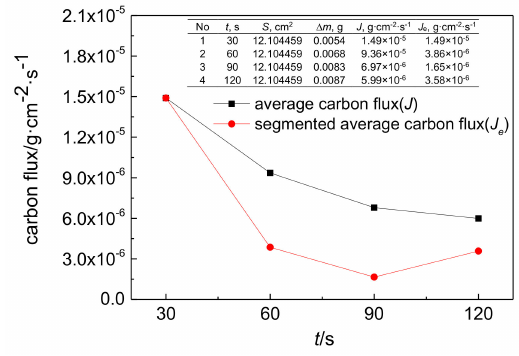
Figure 1. Variation in carbon flux with carburizing time.